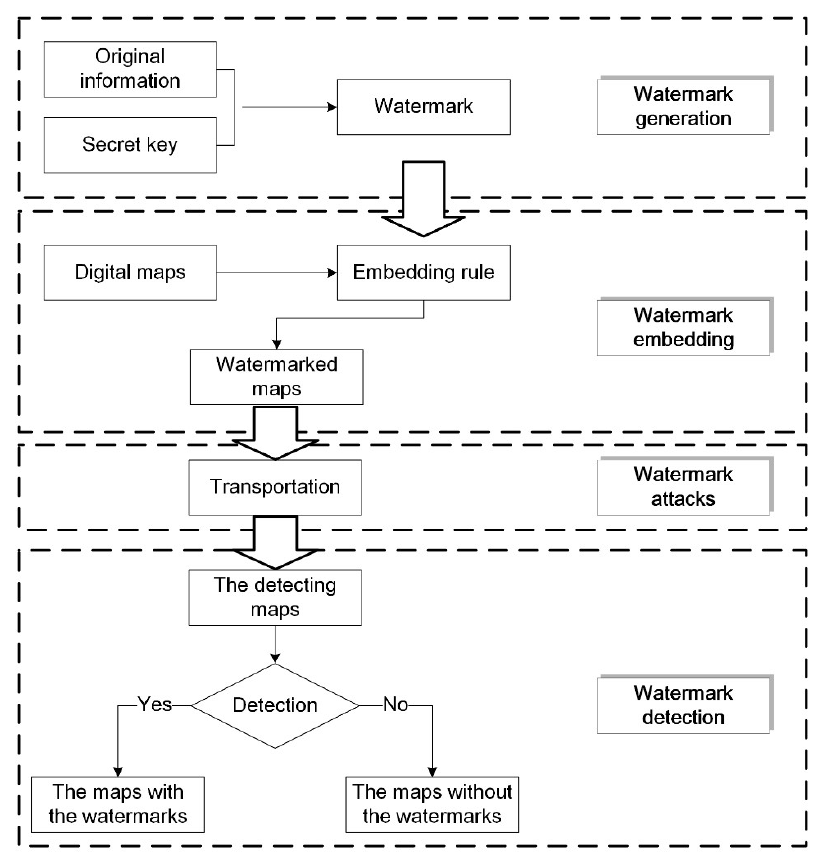
Figure 1. The traditional watermark algorithm.